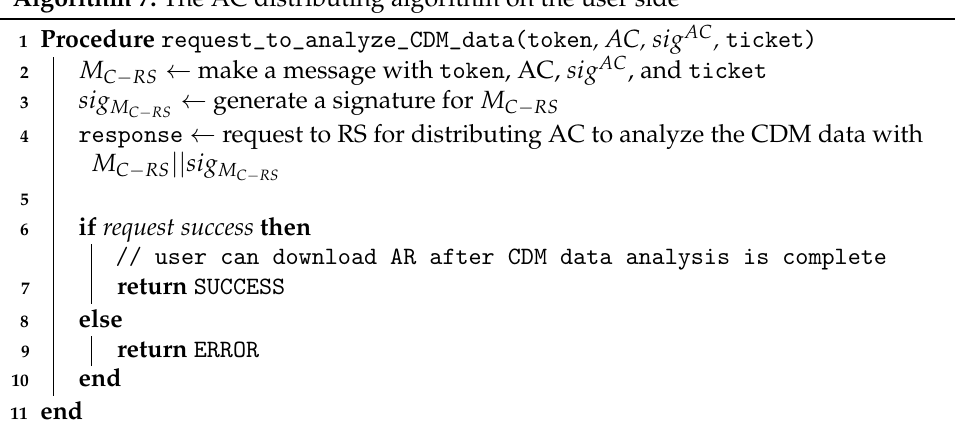
Algorithm 7: The AC distributing algorithm on the user